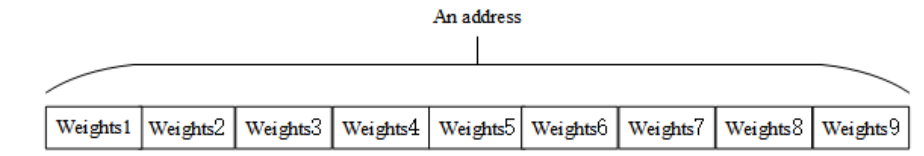
Figure 11. Storage of weight parameters.